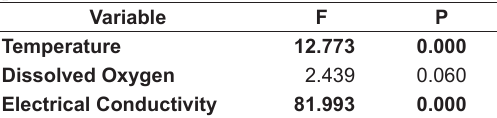
Table 3. ANOVA results: analysis of the influence of month on the variance of temperature, dissolved oxygen and conductivity in Lago Catalão. Significant results (p< 0.05) indicated in bold.